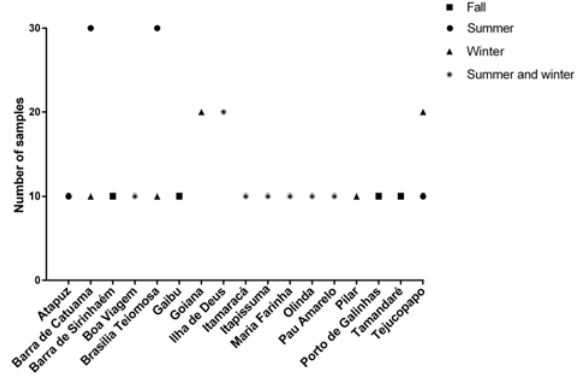
Figure 2. Beach names, number of samples, and seasons of sample collection.